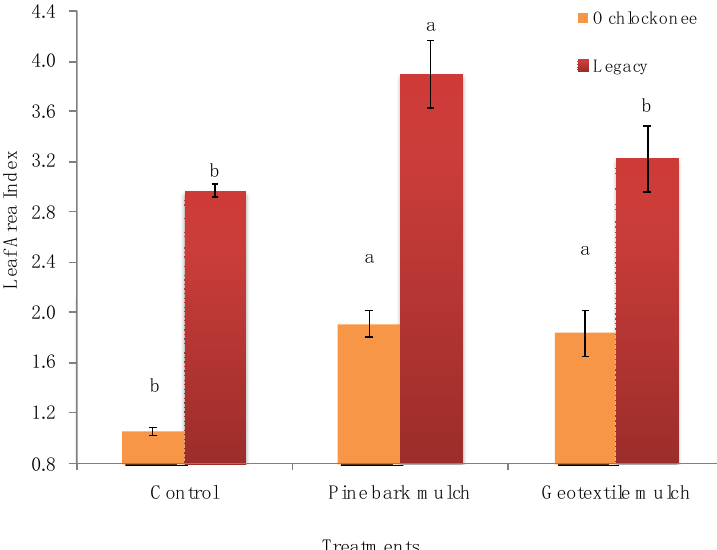
Figure 5. Effects of the different types of mulch on the leaf area index. For each cultivar, different lowercase letters indicate significant differences for different types of mulch, according to the Tukey test ( p < 0.05). The vertical bars correspond to ± the standard error of the mean ( n = 9).